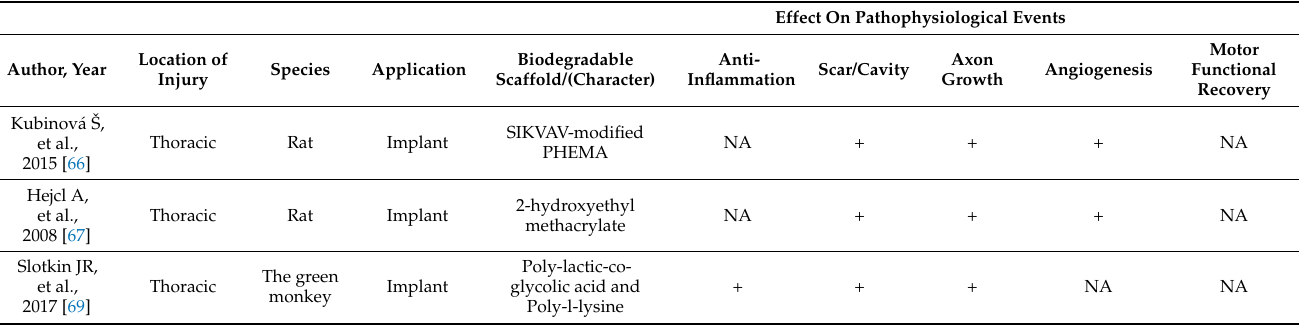
Table 2. Summary of the included studies and the effect of biodegradable scaffolds application in